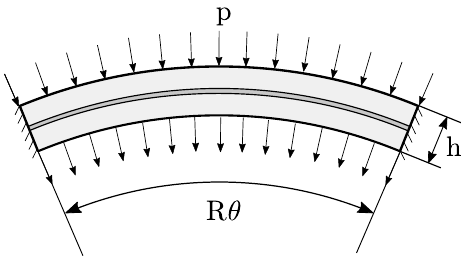
Figure 12. Arch subjected to distributed